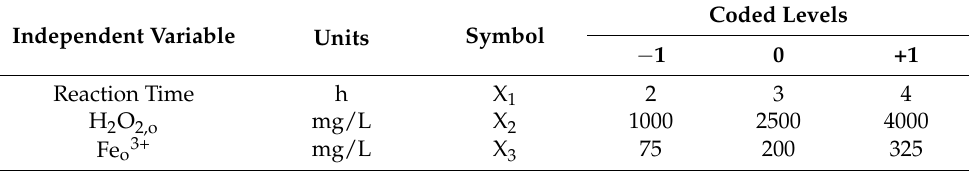
Table 1. Independent Variable Actual and Coded Values Used for Three-Factor, Three-Level BBD. Coded Levels Independent Variable Units Symbol − 1 0 +1 Reaction Time h X 1 2 3 4 H 2 O 2,o mg/L X 2 1000 2500 4000 Fe o3+ mg/L